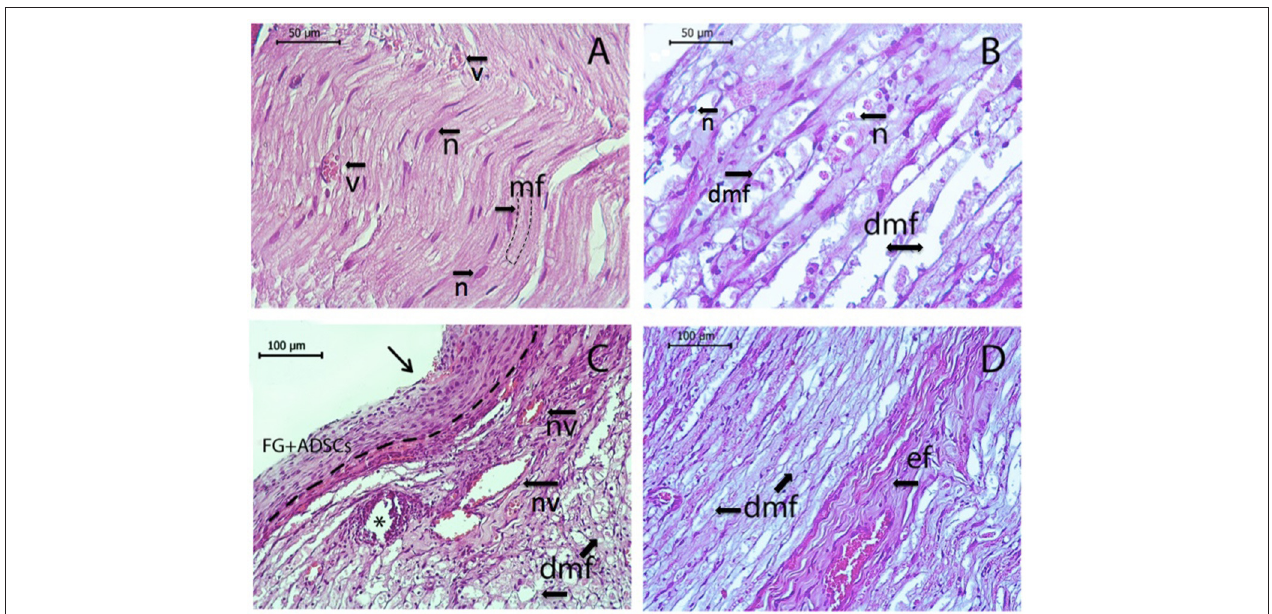
FIGURE 7 | Longitudinal sections of rat sciatic nerve. Intact nerve ( n , nuclei of Schwann’s cells; v, blood vessel; mf, normal myelin fibers) is shown in (A) , sciatic nerve 7 days after the operation is shown in (B–D) . (B) Autotlogus nerve graft area showing degenerated myelin fibers with oedema (dmv) with degenerated nuclei of Schwann’s cells ( n ). (C) Location of nerve anastomosis—central part indicated by arrow, *the needle hole, a dotted line separates epineurium from the top-located fibrin glue with ADSCs, macrophage aggregation, necrotic altered blood vessels (nv) with a hemorrhage area, and degenerated myelin fibers (dmf) under the epineurium. (D) Distal segment of the nerve with degenerative changes of myelin fibers (dmf) and elastic fibers (ef). Hematoxylin and eosin staining. Scale bar (A,B) 50 µ m, (C,D) 100 µ